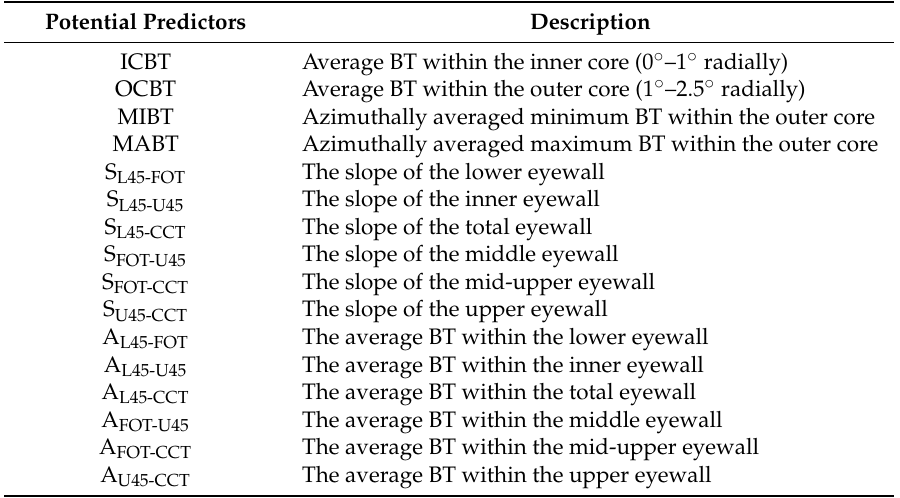
Table 2. Potential predicator pool for intensity estimation from the IR